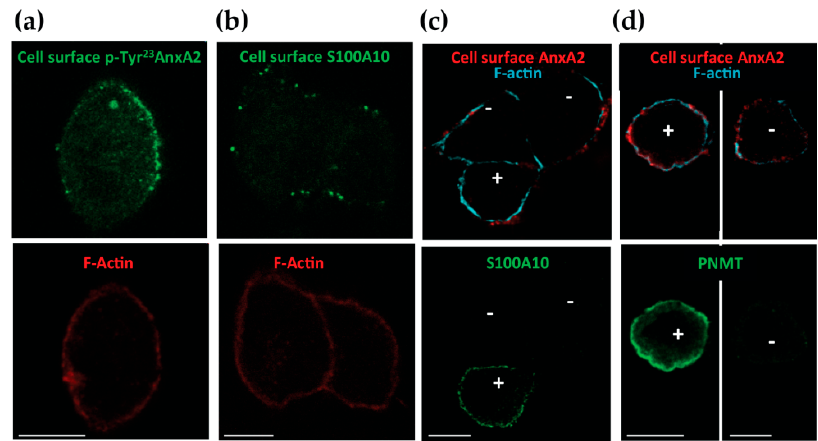
Figure 2. Tyr 23 -phosphorylated AnxA2 and S100A10 are associated with the surface of stimulated chromaffin cells. ( a ) The p-Tyr 23 AnxA2 labeling at the surface of stimulated chromaffin cells. Anti-p-Tyr 23 AnxA2 antibodies were revealed with Alexa Fluor ® 488-conjugated anti-mouse antibodies and F-actin with TRITC-phalloidin to visualize the cell shape. ( b ) S100A10 labeling at the surface of stimulated chromaffin cells. Anti-S100A10 antibodies were revealed with Alexa Fluor ® 488-conjugated anti-mouse antibodies and F-actin with TRITC-phalloidin. ( c ) Confocal micrograph of the triple labeling of cell surface AnxA2, of intracellular S100A10 and of F-actin labeled with Atto-647 N -phalloidin in stimulated chromaffin cells. ( d ) Confocal micrographs of the triple labeling of cell surface AnxA2, of intracellular PNMT and of F-actin labeled with Atto-647 N -phalloidin in stimulated chromaffin cells. For ( a – d ), confocal images were recorded in the same optical section by a dual exposure procedure. Scale bar: 10 µM.